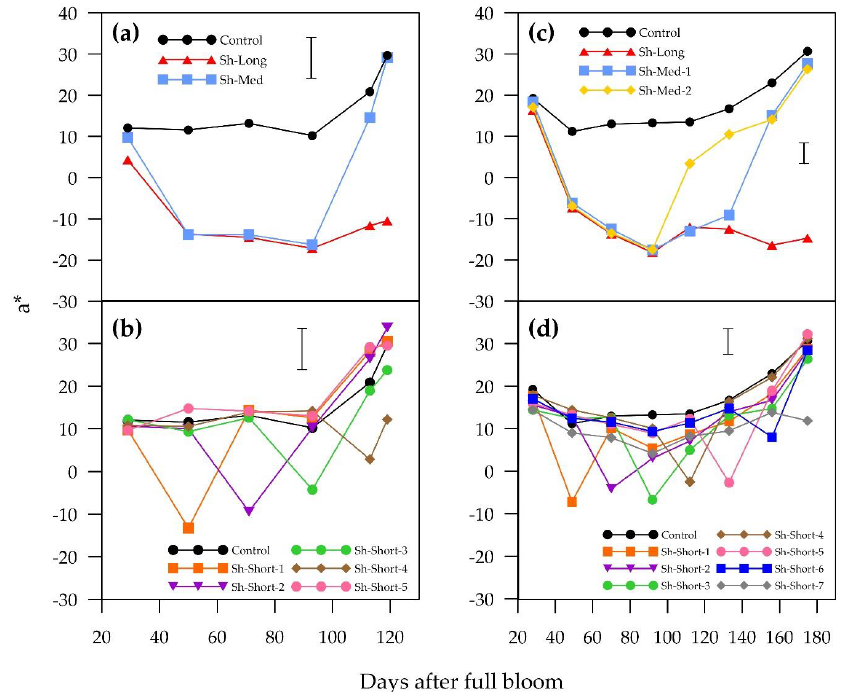
Figure 2. Temporal patterns of change in means of a* for “ANP-0118” ( a = long and medium shading treatments; b = short shading treatments) and “ANP-0131” ( c = long and medium shading treatments; d = short shading treatments). The control is displayed alongside treatments. Error bar represents Fisher’s LSD at 5% level of significance.